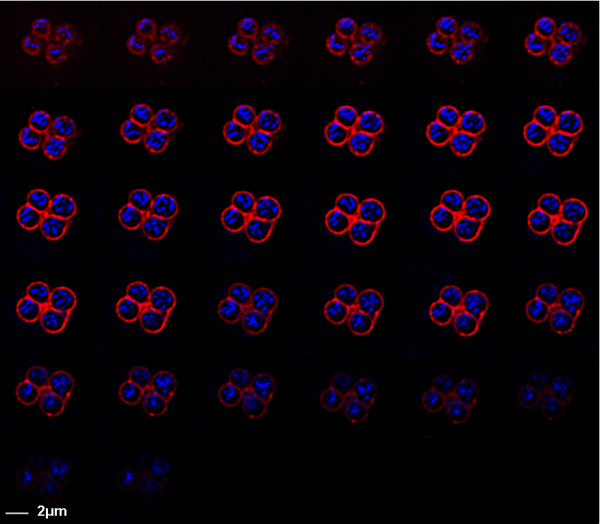
Optical sections of a D. geothermalis tetrad. The series is in order from left to right of the images within a row and from top to bottom of the rows within the figure. Images are taken at 100 nm intervals.